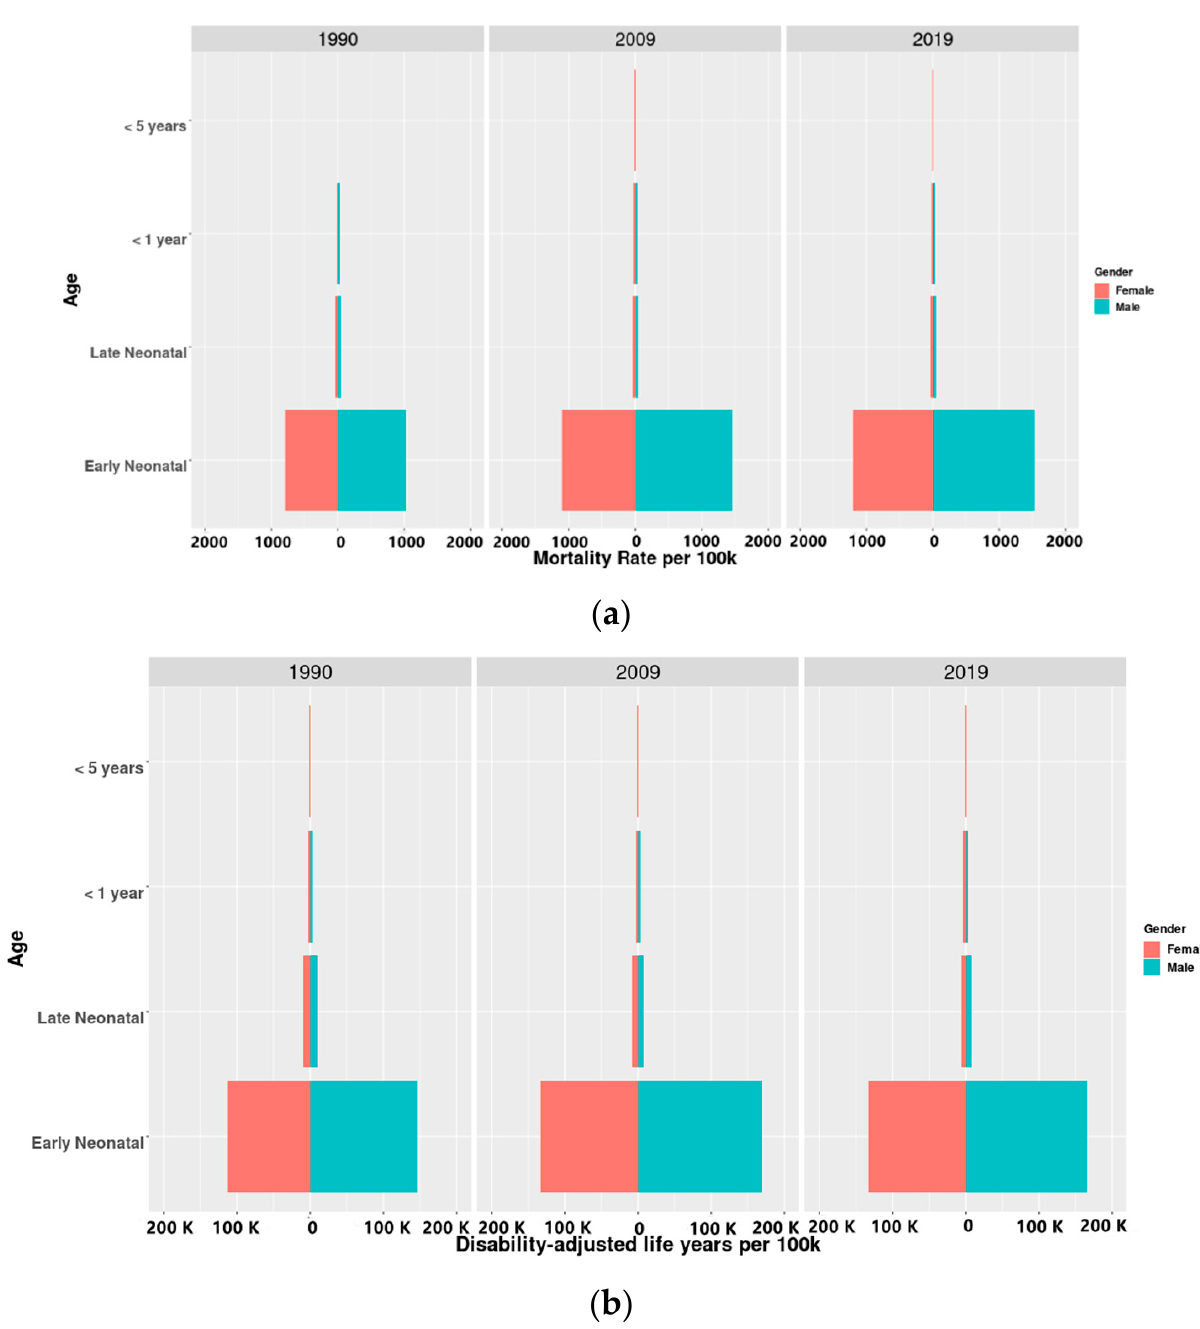
Figure 3. ( a ) Mortality rates (per 100,000 people) of PM 2.5 -related preterm birth in the world in different sex and age groups in 1990, 2009, and 2019. ( b ) Disability-adjusted life years rates (per 100,000 people) of PM 2.5 -related preterm birth in the world in different sex and age groups in 1990, 2009, and 2019.